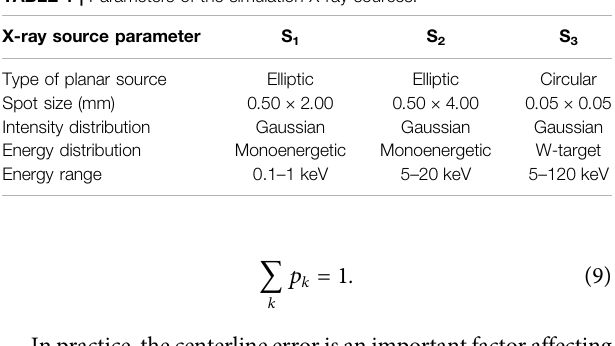
TABLE 1 | Parameters of the simulation X-ray